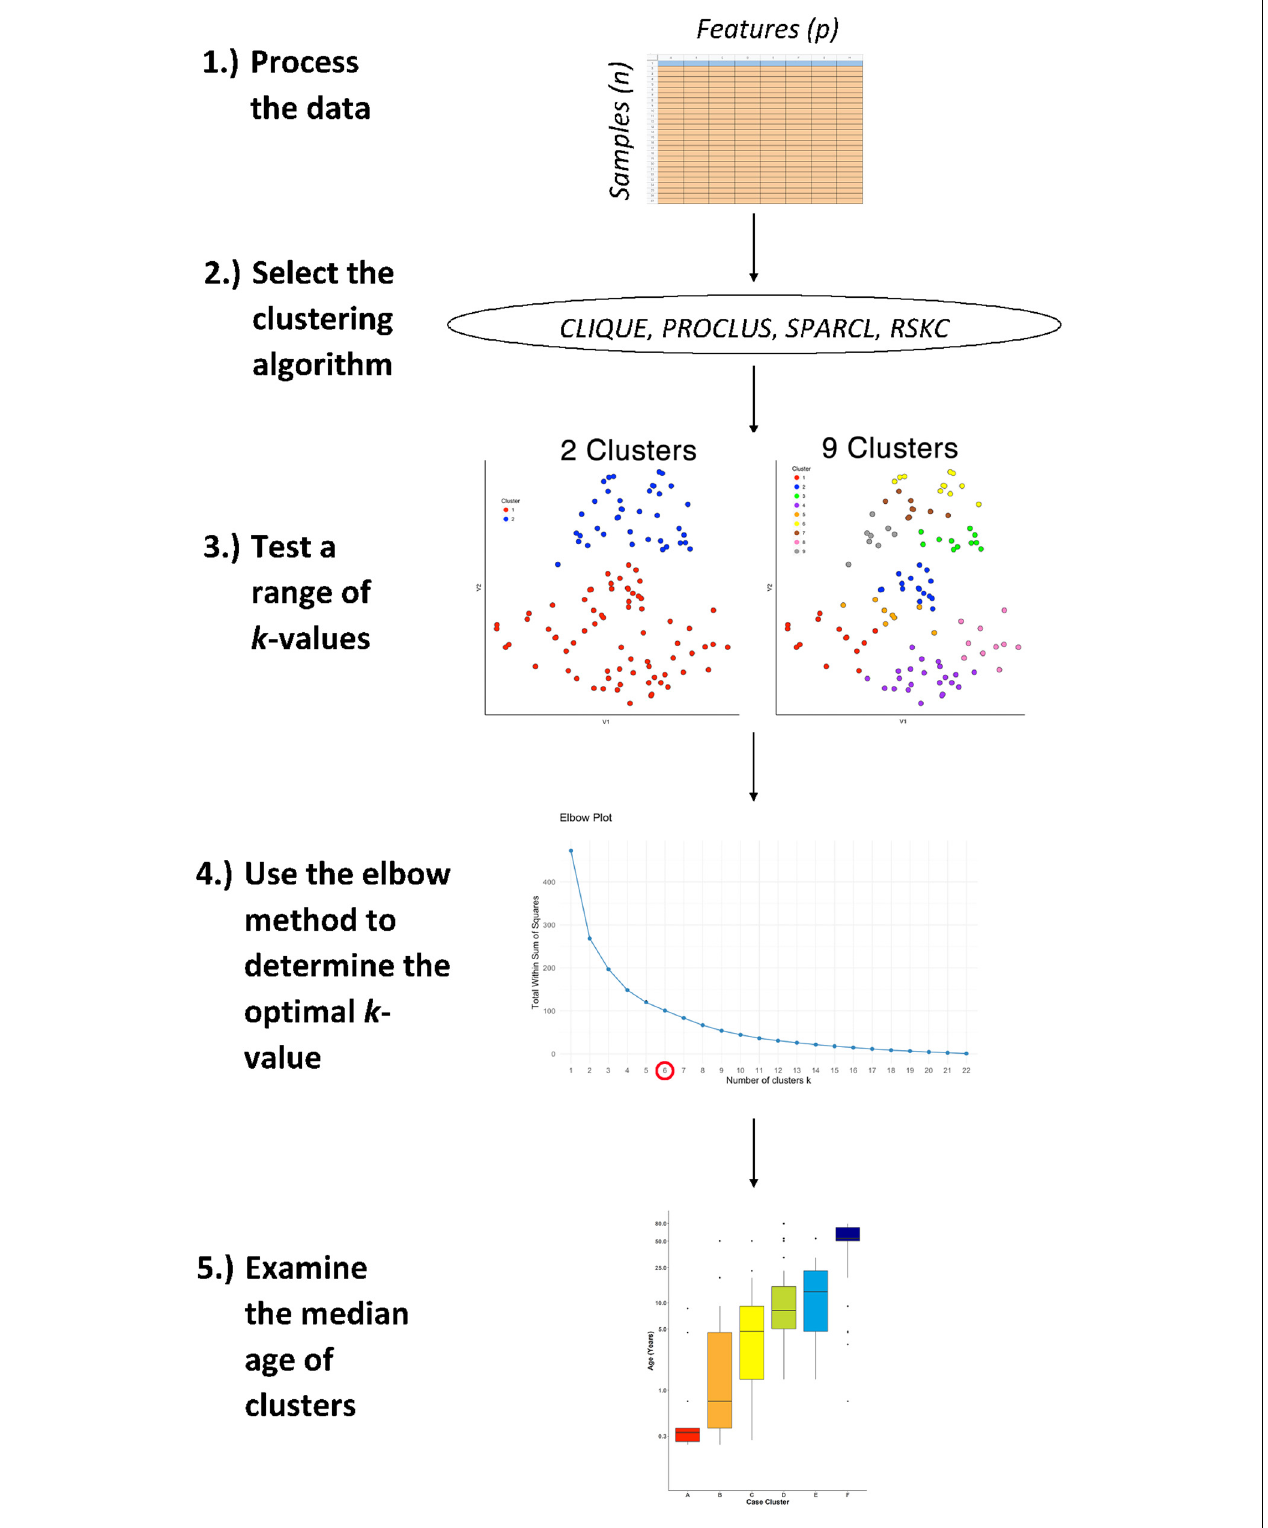
FIGURE 1 | The workflow for studying age-related molecular development of the brain. First, arrange the data into an n × p matrix, where features ( p ) are represented as columns and samples ( n ) as rows. Then, select the desired sparse clustering algorithm (e.g., CLIQUE, PROCLUS, SPARCL, and RSKC) and test its performance along a range of clusters ( k ). Lastly, determine the optimal k value using the elbow method and compare the median age of clusters with boxplots.